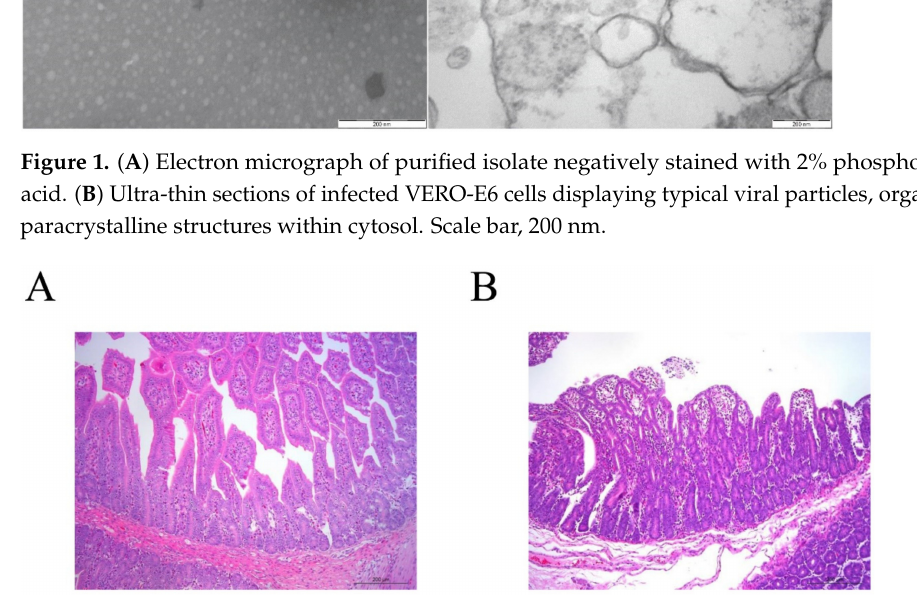
Figure 2. Pathology of jejunum villi of piglet samples: ( A ) control and ( B ) diseased